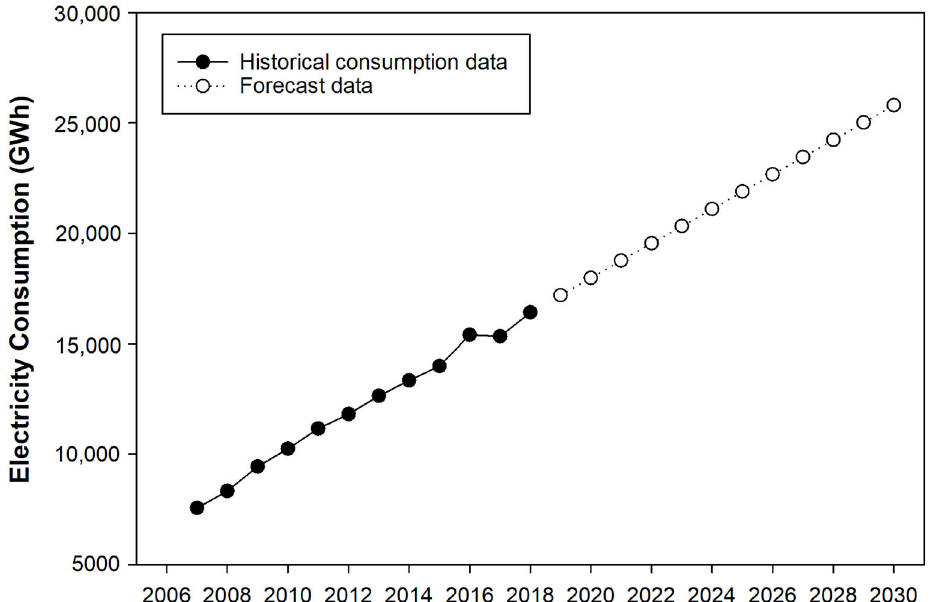
Figure 5. Electricity consumption forecast using Holt–Winters.